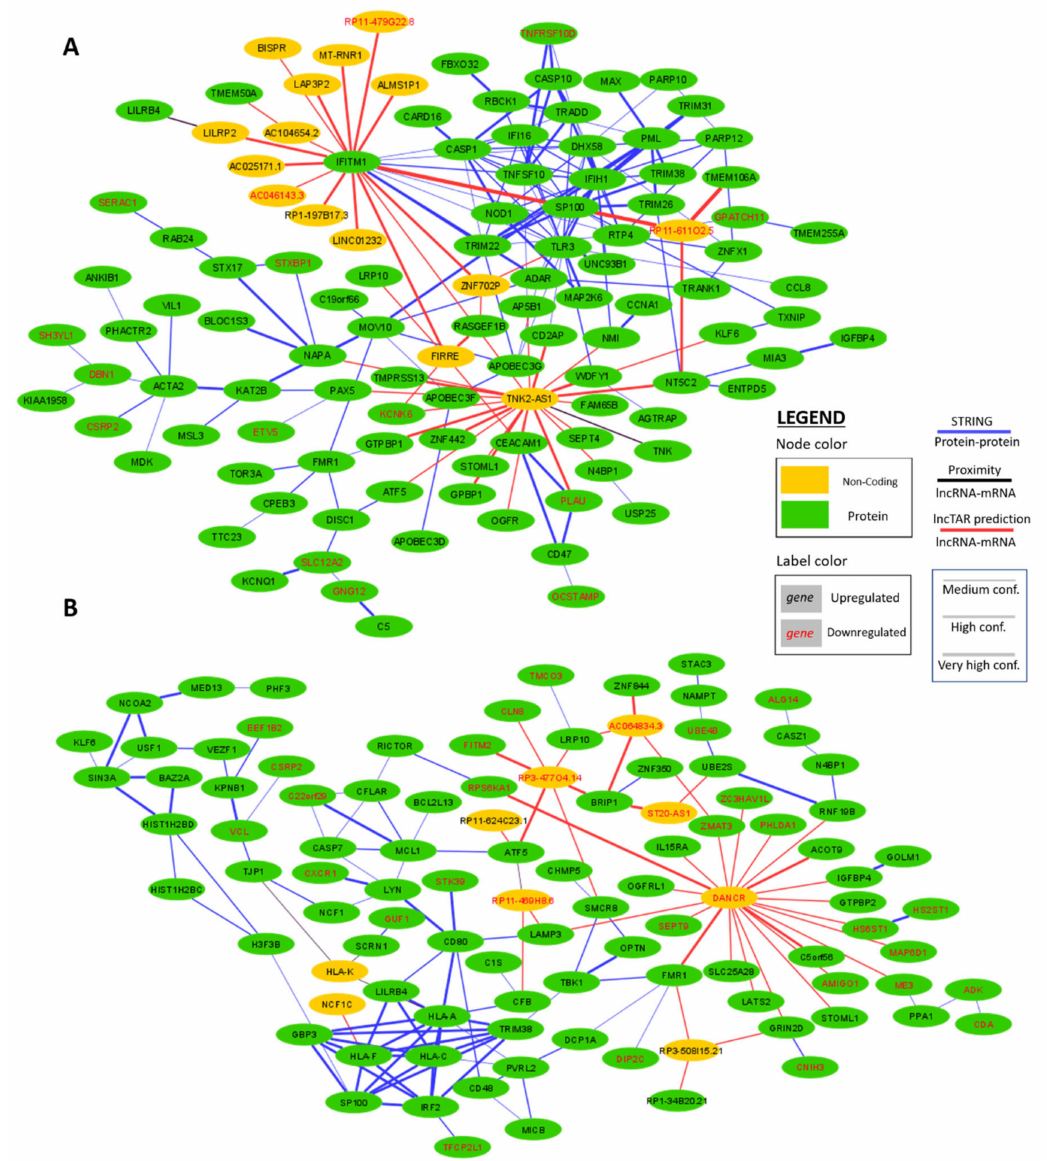
Figure 4. Networks displaying the predicted interactions between the di ff erentially expressed (hub) genes of the brown module for: ( A ) IFN- α stimulation; and ( B ) IFN- ε stimulation. Three interaction types are depicted: (1) protein–protein interactions determined with the STRING webtool [24]; (2) Poly-A + ncRNA–mRNA interactions predicted by LncTAR based on the binding free energy between the mRNA and the lncRNA sequences [25]; and (3) ncRNA–mRNA interactions based on genomic co-localization